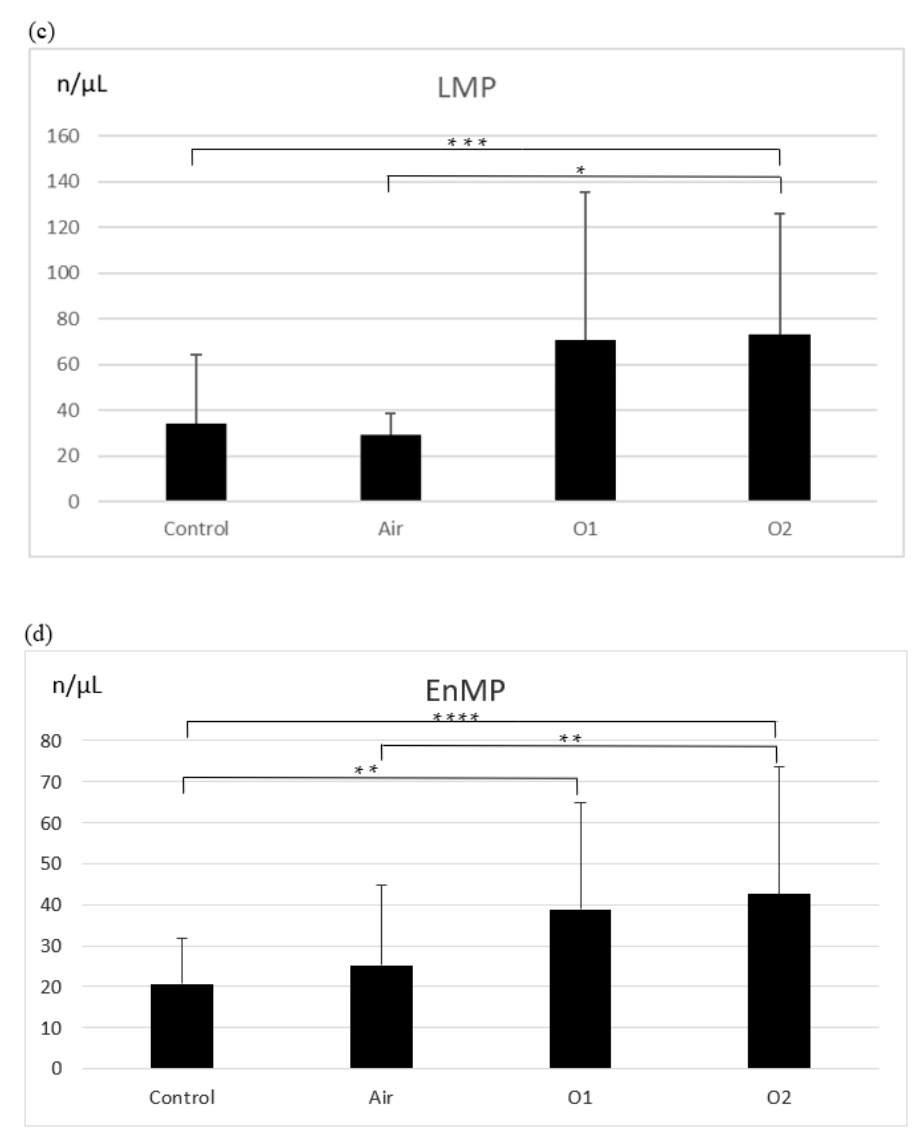
Figure 1. The effect of ozone on microparticle generation from platelets ( a ), erythrocytes ( b ), leukocytes ( c ), and endothelial cells ( d ). PMP—platelet-derived microparticles, ErMP—erythrocyte-derived microparticles, LMP—leukocyte-derived microparticles, EnMP—endothelial cell-derived microparticles, control—the control group ( n = 19); Air—the aerated group ( n = 19); O1—the group treated with ozone at a dose of 15 µg/mL ( n = 19); O2—the group treated with ozone at a dose of 30 µg/mL ( n = 19). Mean ± SD, statistically significant difference between the groups (* p < 0.01; ** p < 0.005; *** p < 0.0005; **** p < 0.0001).